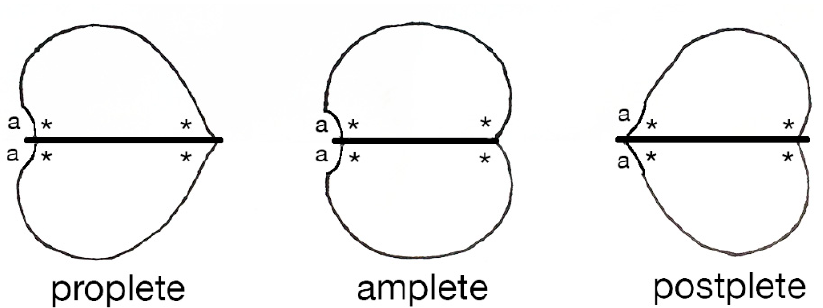
Figure 3. Proplete, amplete, and postplete bradoriid shield pairs. Most bradoriids develop postplete shields. Anterior to the left. Asterisk (*) denotes cardinal corners; “a” denotes anterodorsal cardinal corner marginal concavity. The relative height of each shield is measured by the distance it extends from the hinge line (black horizontal line); all three of the examples shown here have the same shield height. Image Credit: Mark